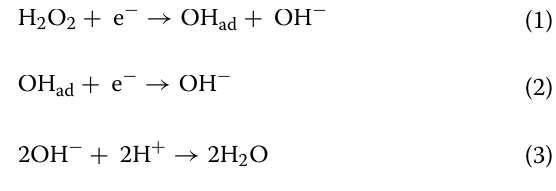
Table 1 Sensing performances on comparison of Co Materials